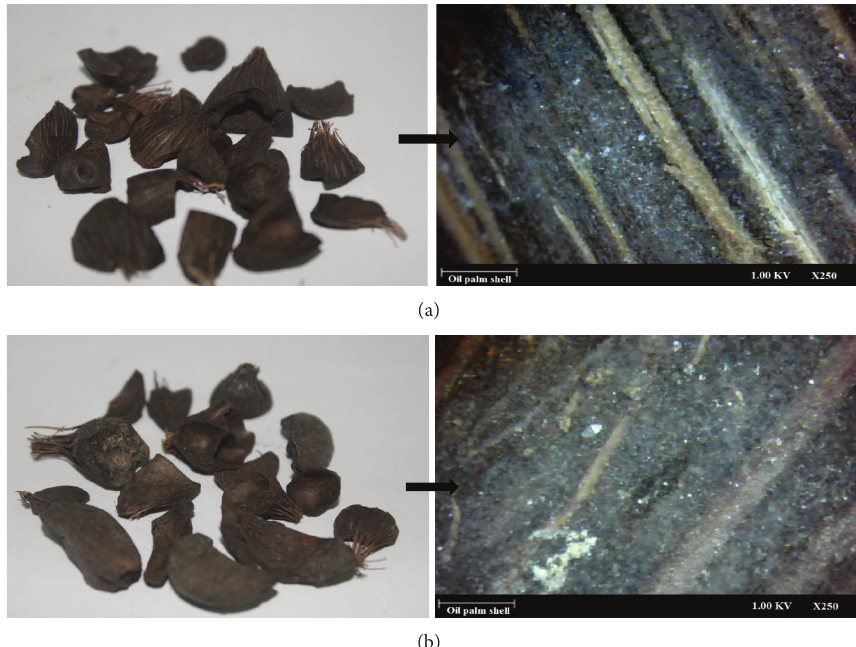
Figure 4: Images (left) and microscopic images (right) of crushed OPS aggregates: (a) with heat treatment and (b) without heat treatment.